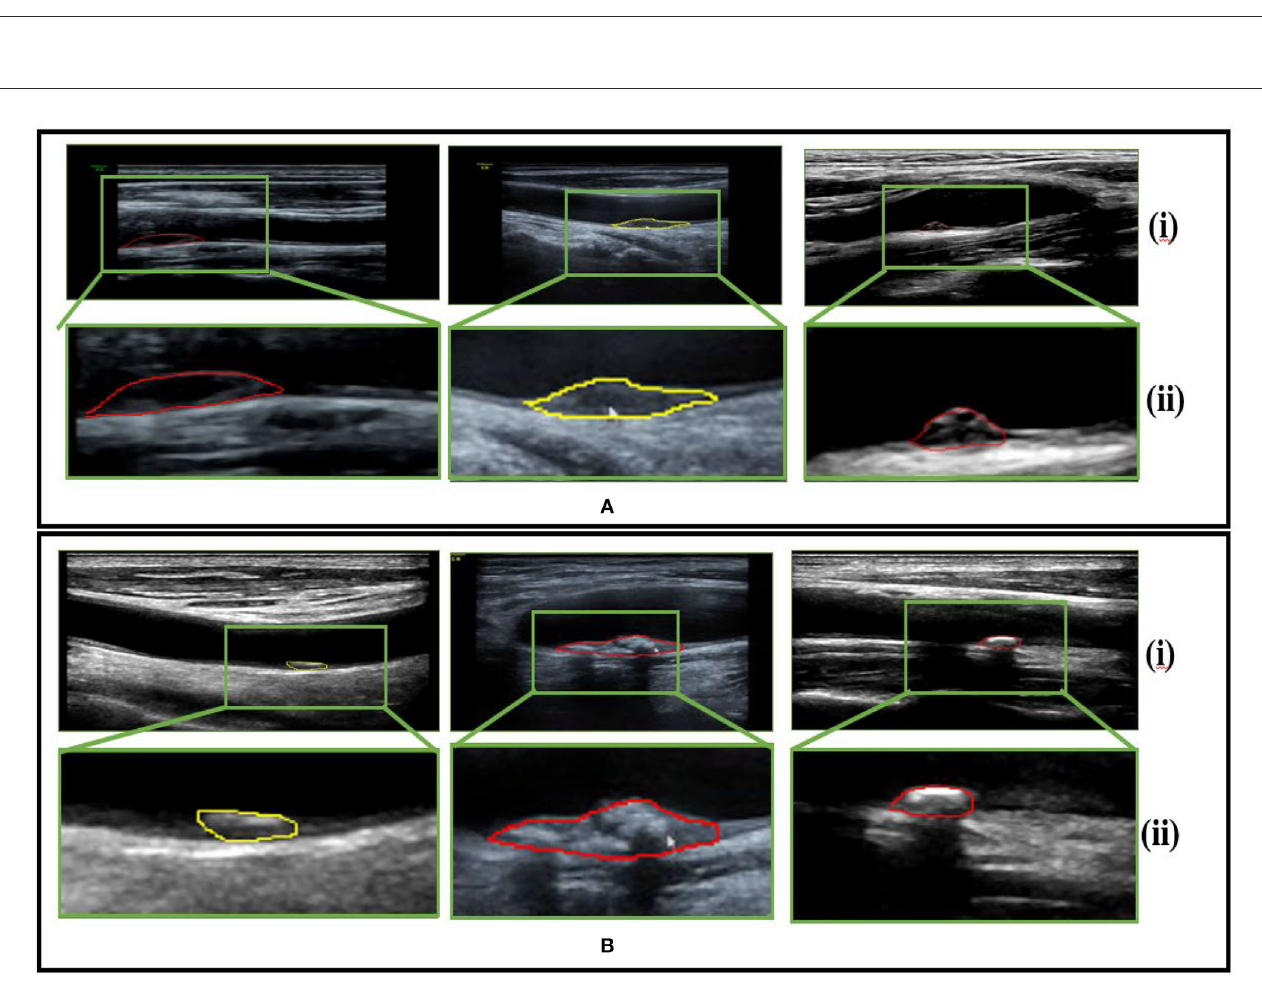
FIGURE2 Sample dataset (A) pertains to vulnerable carotid plaque ultrasounds images scans and (B) belongs to stable carotid plaque ultrasounds images scans, whereby (i) and (ii) represent the color Doppler image scans and their respective enlarged views for